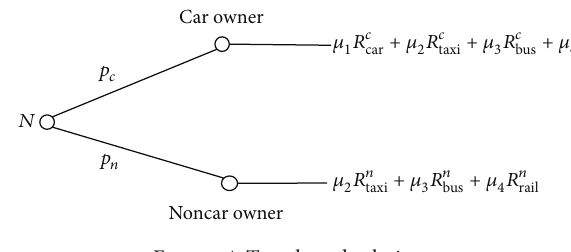
Figure 4: Travel mode choice